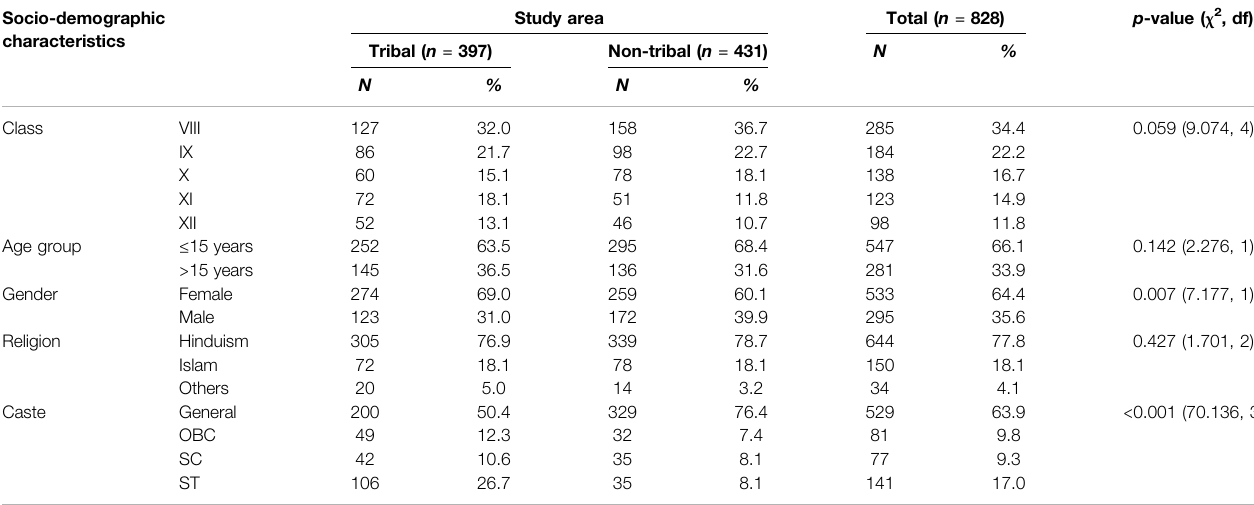
TABLE 2 | Distribution of students according to socio-demographic characteristics and study